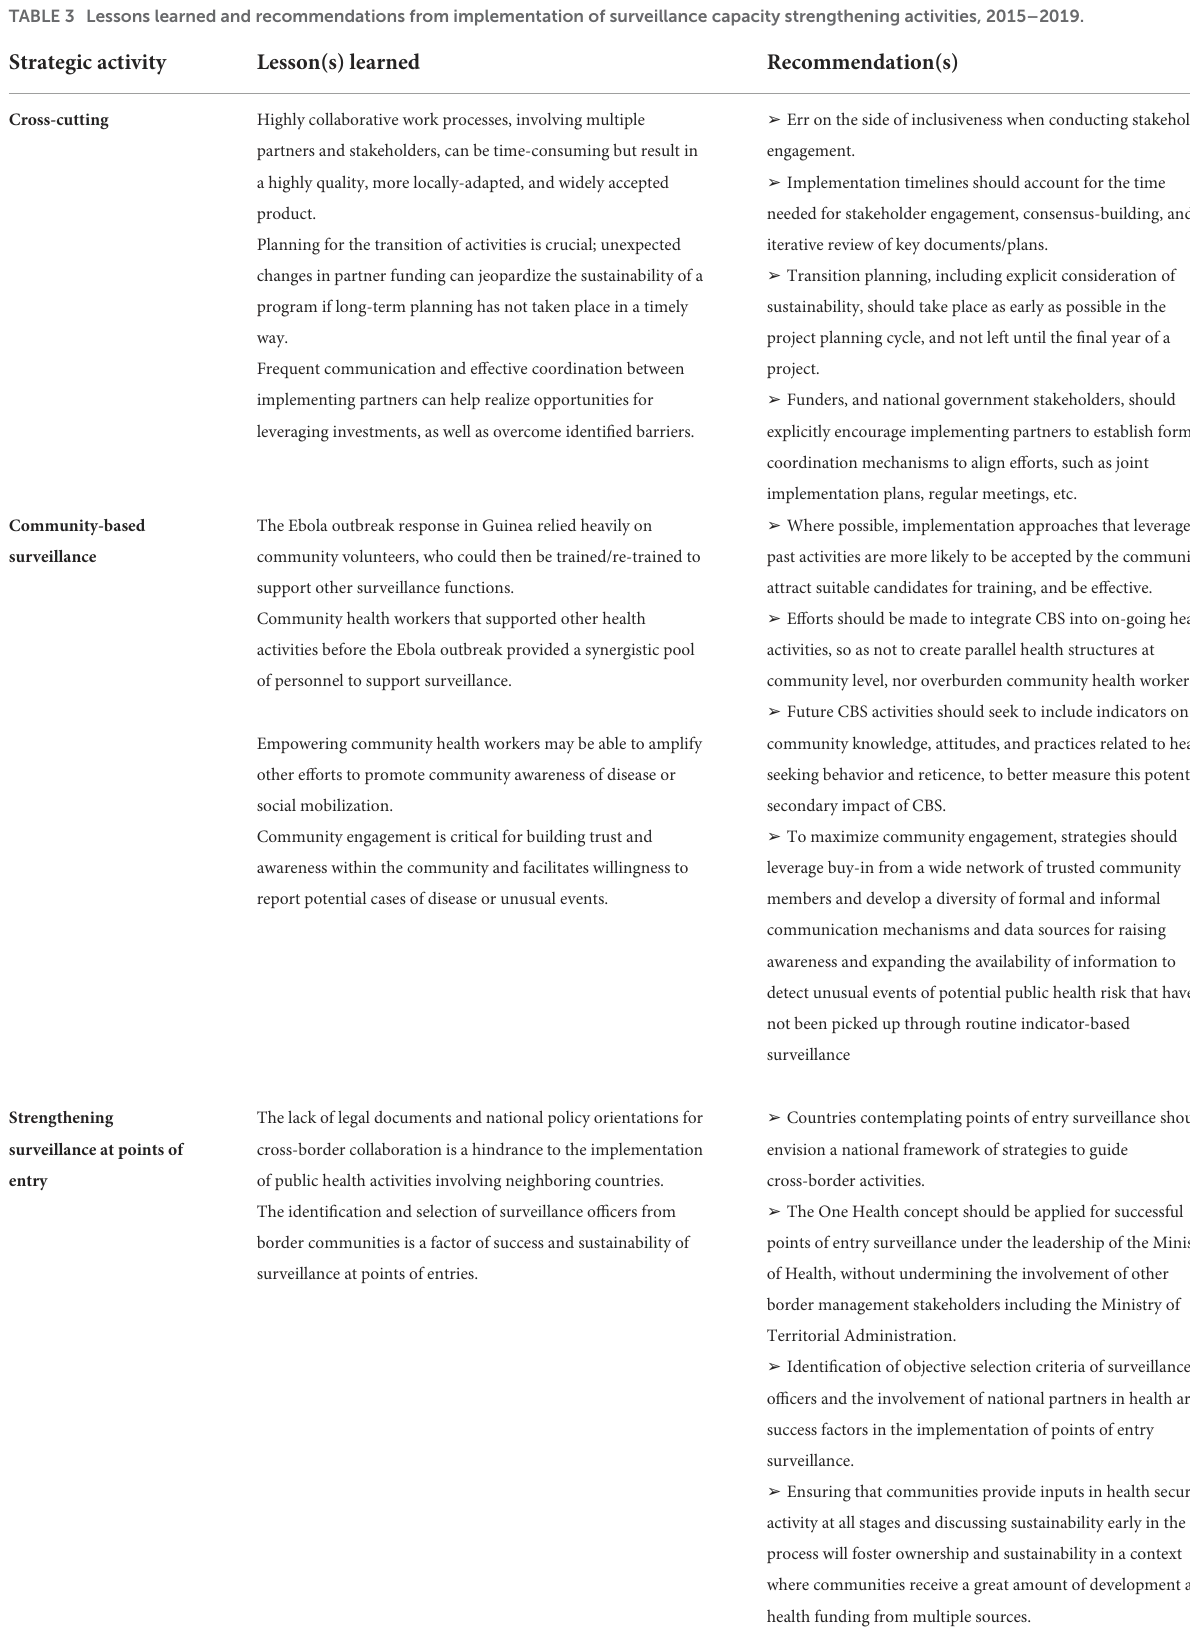
TABLE 3 Lessons learned and recommendations from implementation of surveillance capacity strengthening activities,